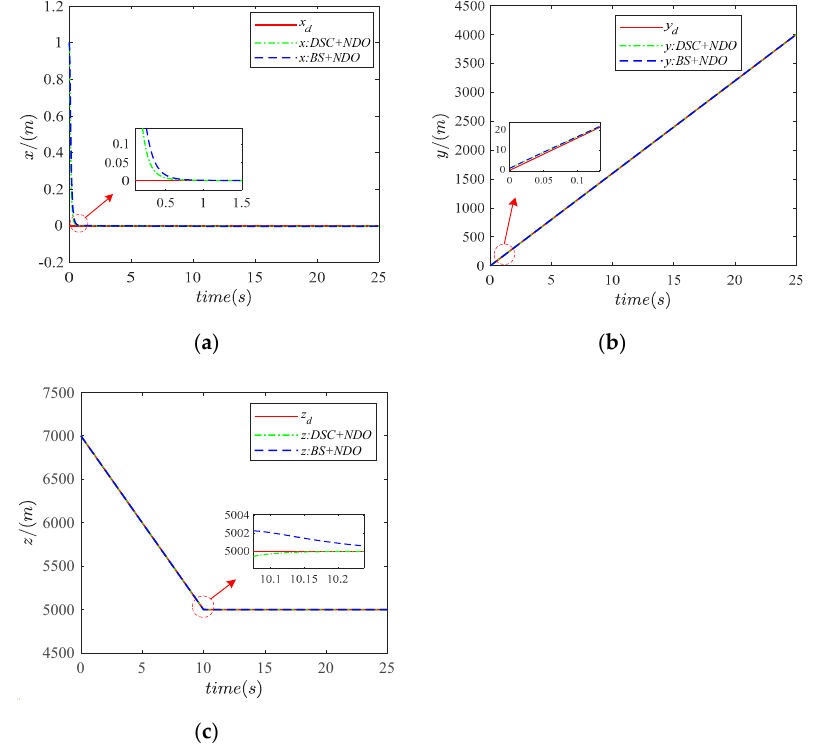
Figure 7. MAV trajectory tracking curves: ( a ) x-direction; ( b ) y-direction; ( c ) z-direction.